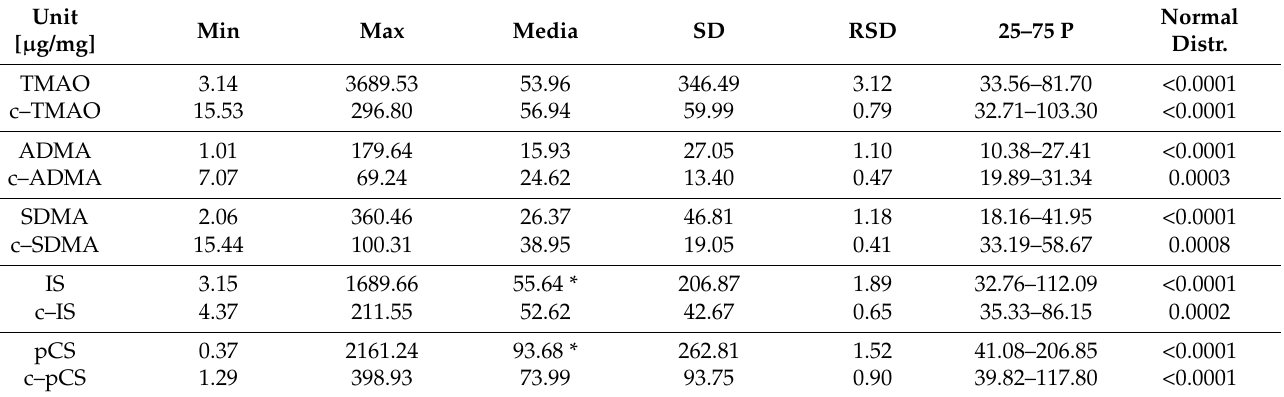
Table 1. Levels of uremic toxins in urine samples in study groups (ASD, N = 143; controls, N = 48).